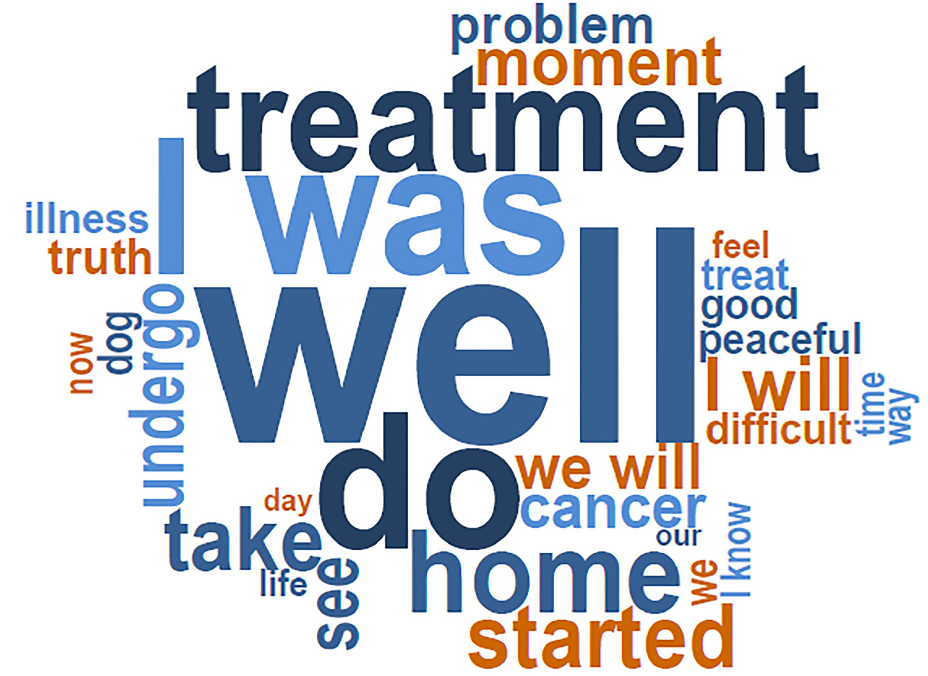
Figure 4. Word cloud generated from the transcript of the interviews with the owners, using the NVivo software. (*) Translator’s note: the word clouds were generated from the transcript of the interviews in Portuguese and translated to English keeping the original layout. Verbs in Portuguese are inflected differently for each grammatical person, so the use of a pronoun is necessary to keep their accurate meaning in